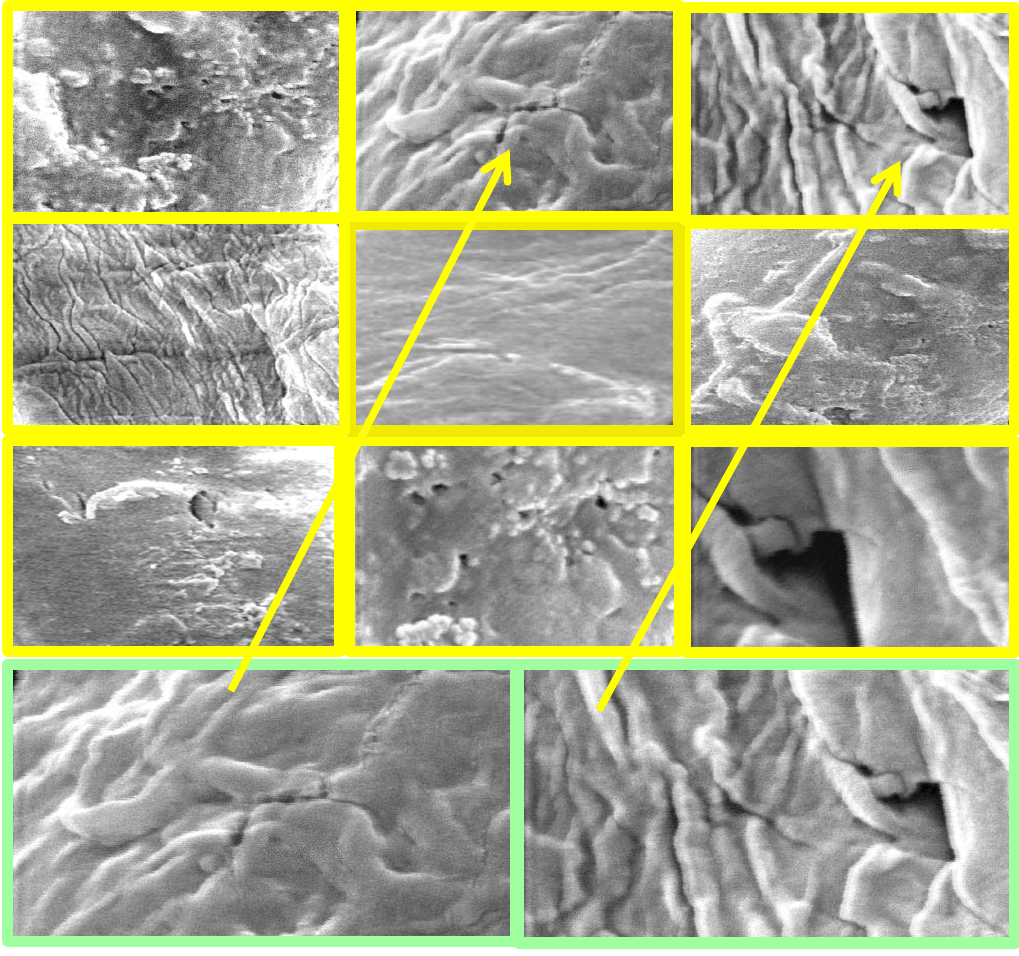
Fig. 3. Flow chart of the Figure 3 . Flow chart of the experiment